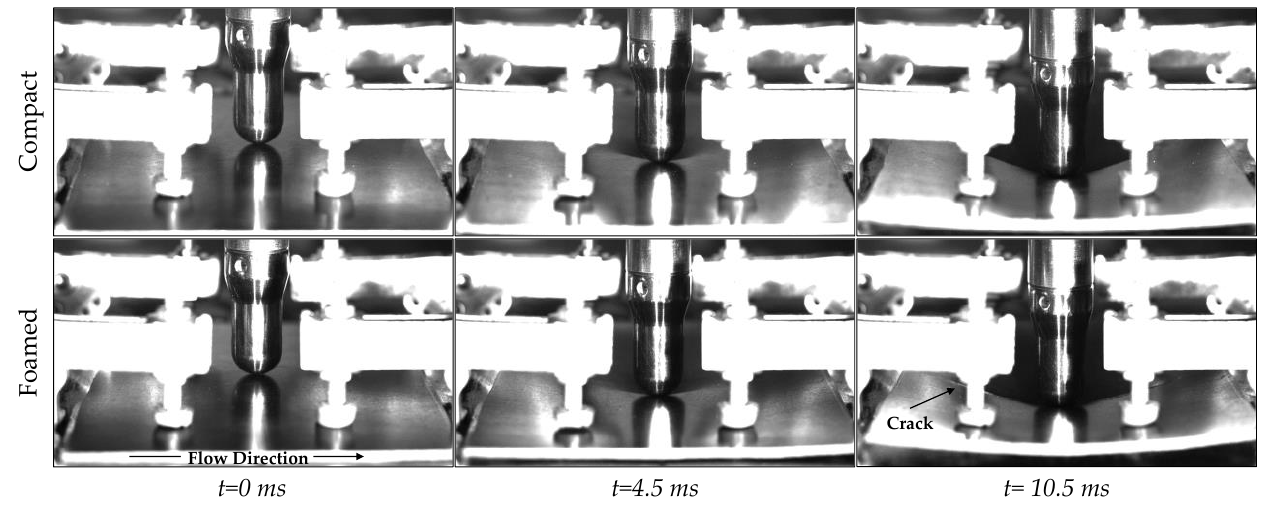
Figure 18. High speed camera images showing the impact event, the bending, and the deformation and fracture of a compact and foamed specimen.